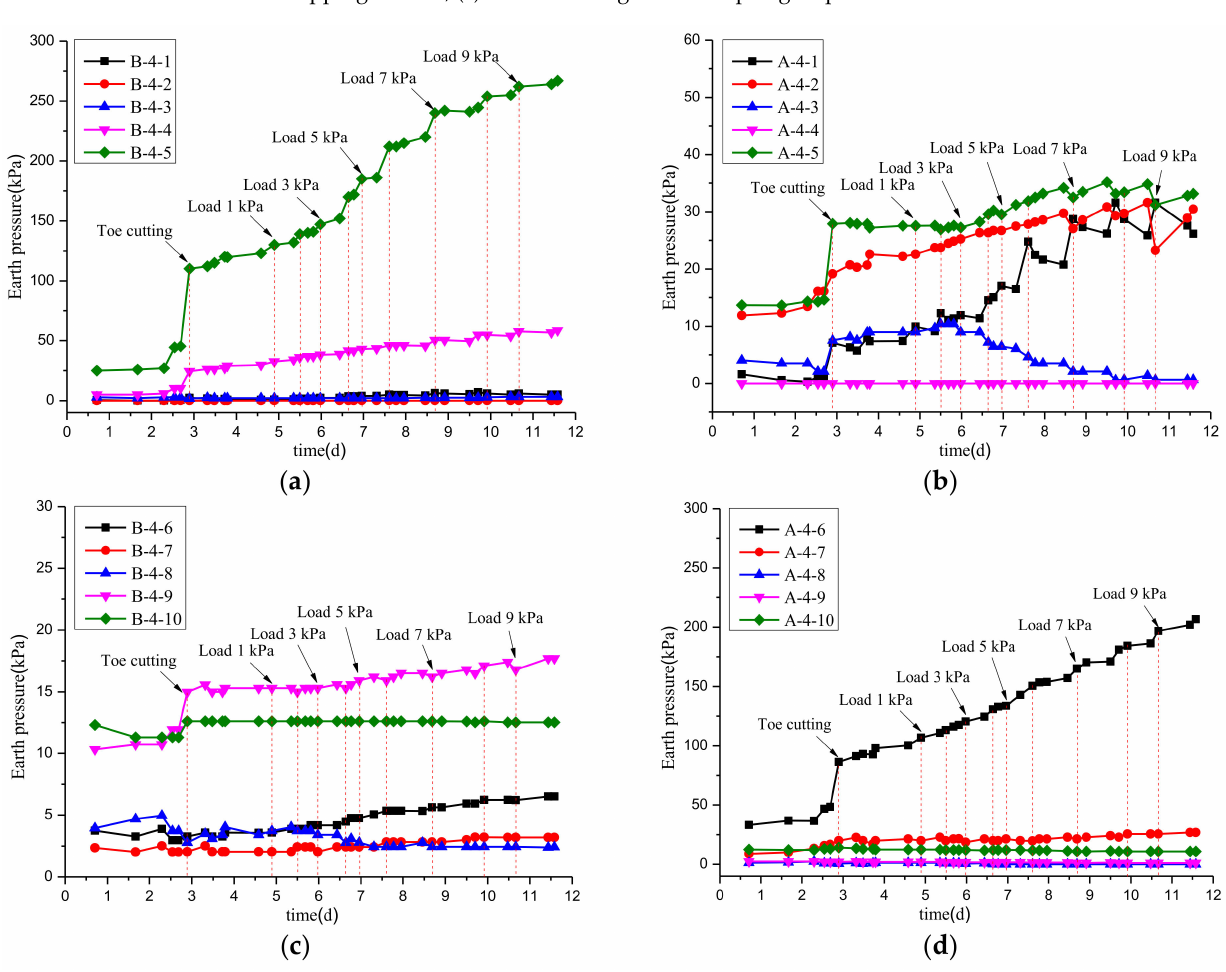
Figure 10. Earth pressure of pile no. 4: ( a ) curves of earth pressure before the anti-sliding segment of pile no. 4; ( b ) curves of earth pressure behind the anti-sliding segment of pile no. 4; ( c ) curves of earth pressure before the anchoring segment of pile no. 4; ( d ) curves of earth pressure behind the anchoring segment of pile no.